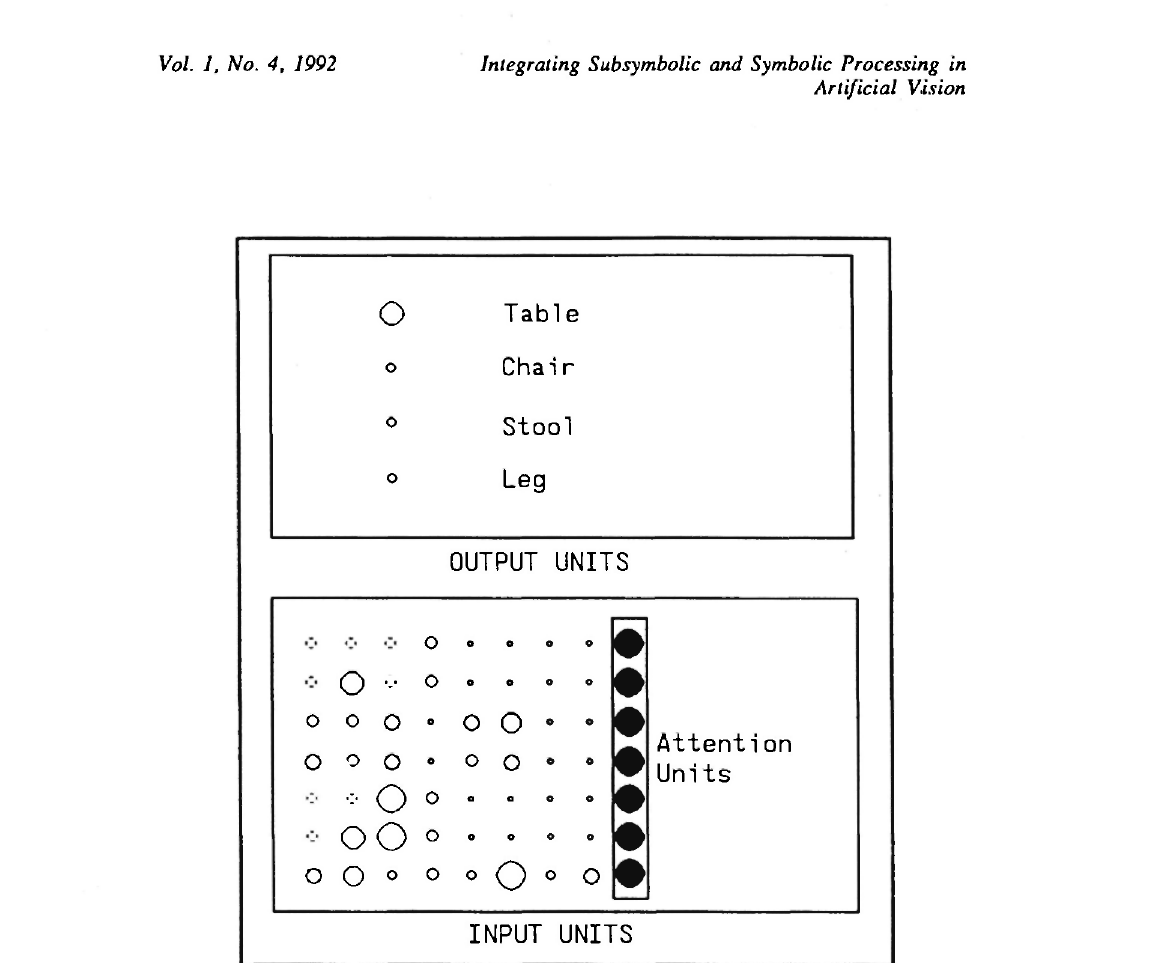
A screen hardcopy of the simulator. Each unit is represen- ted by a circle whose size is proportional to unit activation. White circles stand for positive activations while black circles for null activations. The input units and the selec- tion of attention units are shown on the bottom of the figure: the first eight units of each row correspond to the superquadric parameters, while the last unit is the selection of attention unit. The output units are shown on the top of the figure. The input activation pattern is related to a table and no attention units are activated. The most active output unit is, as expected, the one related to the class of